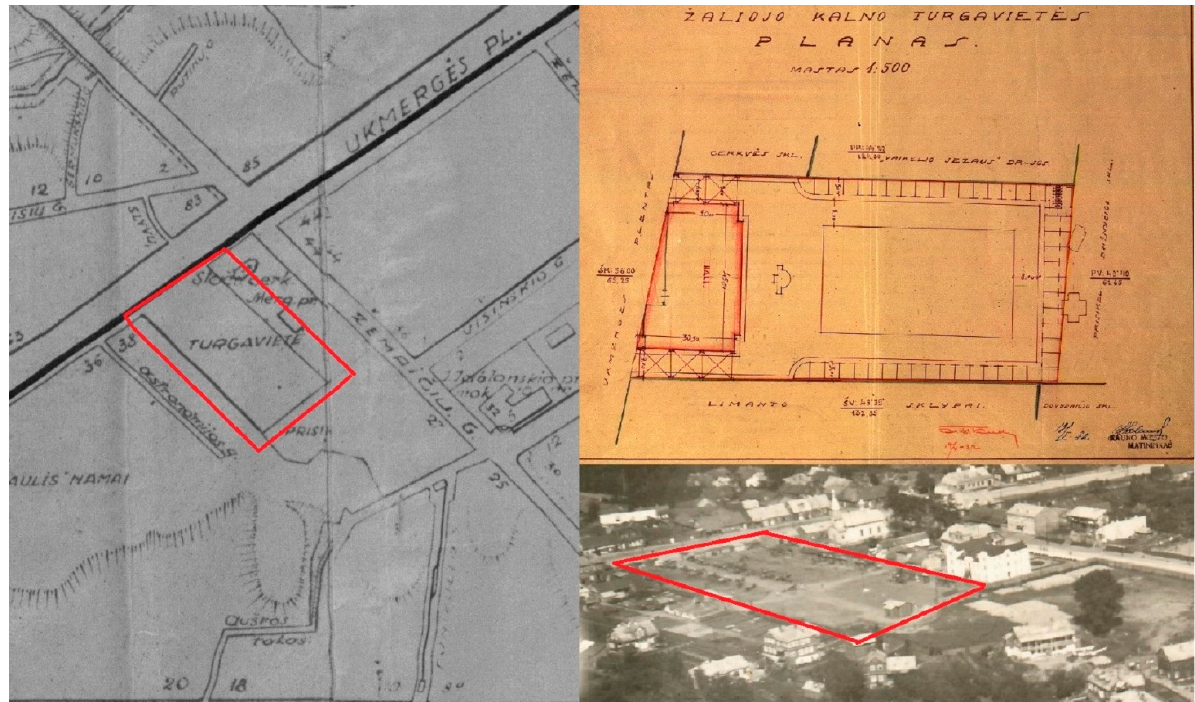
Figure 4. The location of the marketplace is marked with red lines (source: Kaunas Regional State Archives).